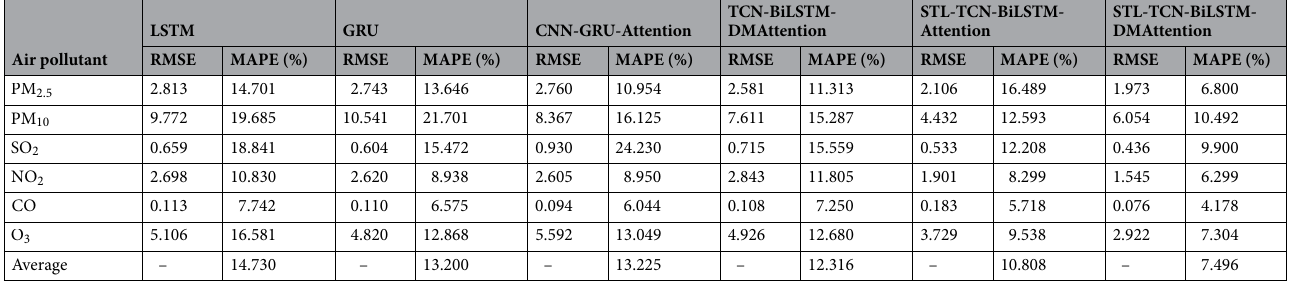
Table 3. Forecast error of different